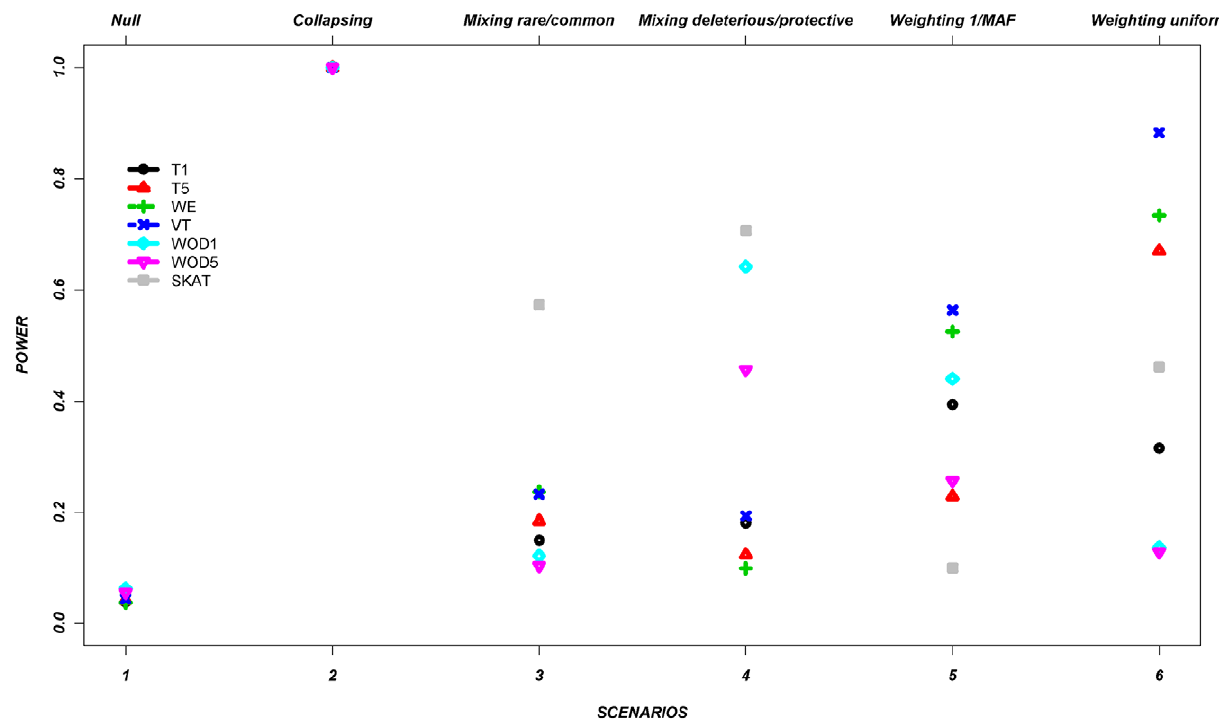
Figure 1. Power across all methods, per scenario, as described in Table 1, for the average across the seven genes. Footnote: Note that in some scenarios, different methods overlap. This is the case for scenario 1 and 2, where all methods give similar